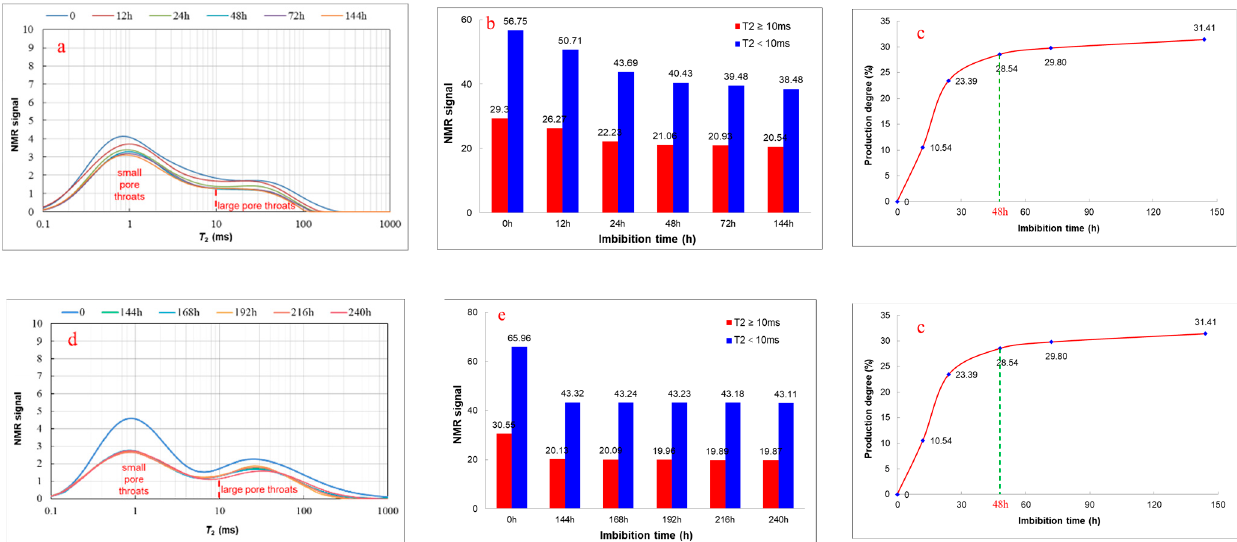
Figure 15. Imbibition NMR results of core samples of type IV reservoir; ( a , d ) are the T 2 spectrum of imbibition NMR of IR-04 and IR-05, respectively; ( b , e ) are the histogram of NMR signal at different imbibition times of IR-04 and IR-05, respectively; ( c , f ) are the variation of production degree of crude oil in the pore throats of IR-04 and IR-05, respectively.